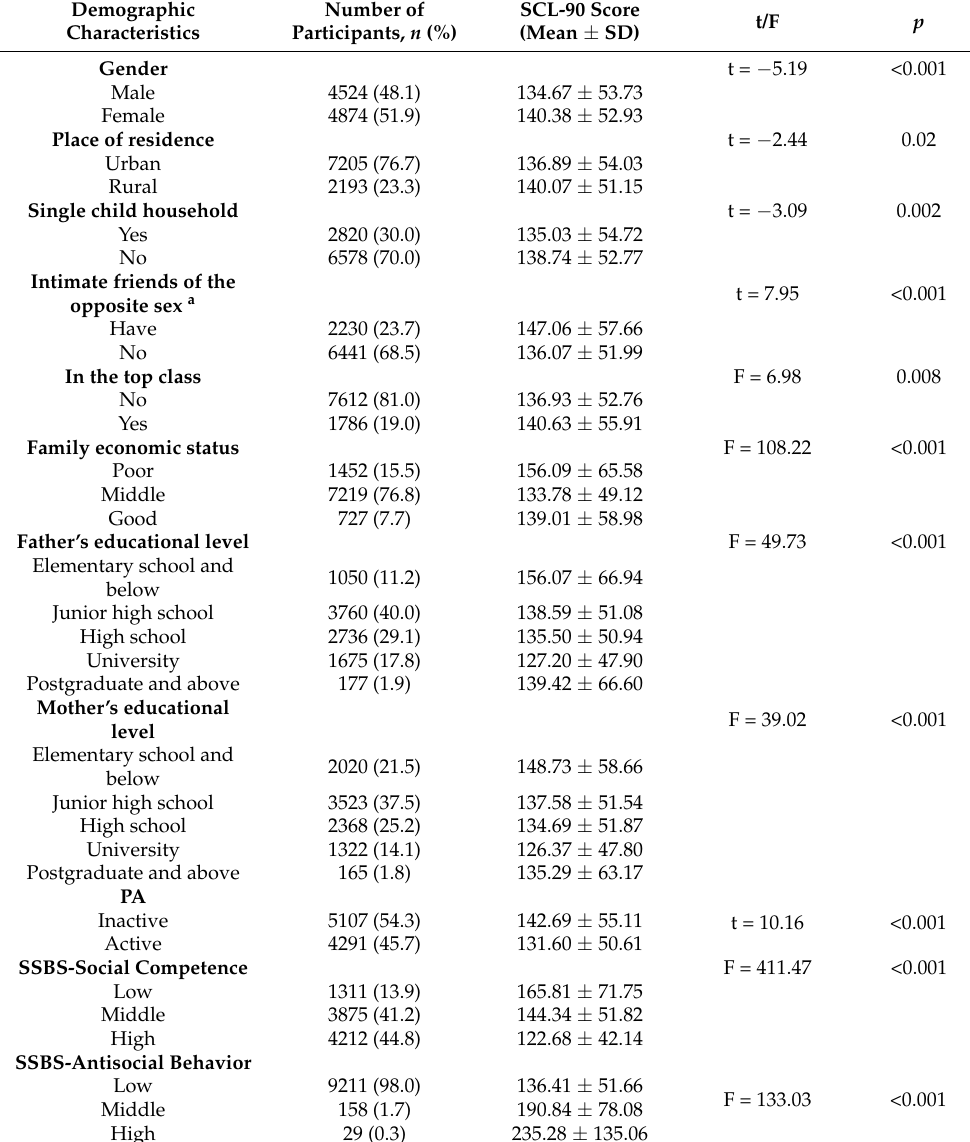
Table 1. Participants’ demographic characteristics and results of self-reported mental health problems, N =